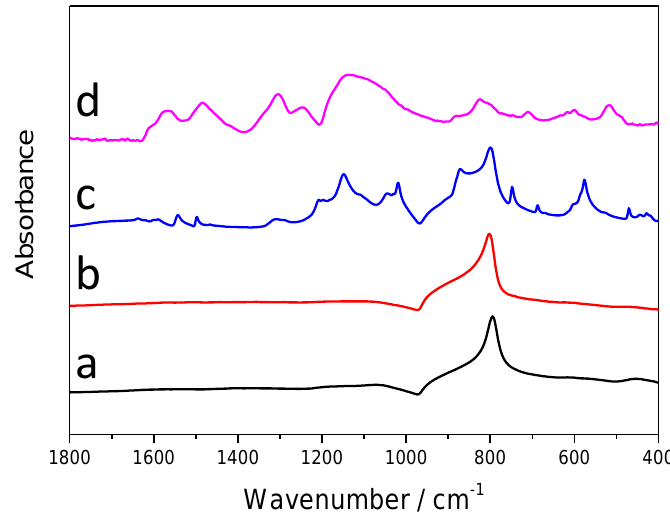
Figure 5. Infrared (IR) spectra of the synthesized nanocomposite samples and their components: ( a ) SiC; ( b ) SiC/PANI, 60 min UV-illuminated; ( c ) SiC/PANI, 60 min UV-filtered; ( d ) bare PANI. Table 2. Characteristic IR bands of PANI. The bands appearing on the spectra of the nanocomposites are marked with grey.